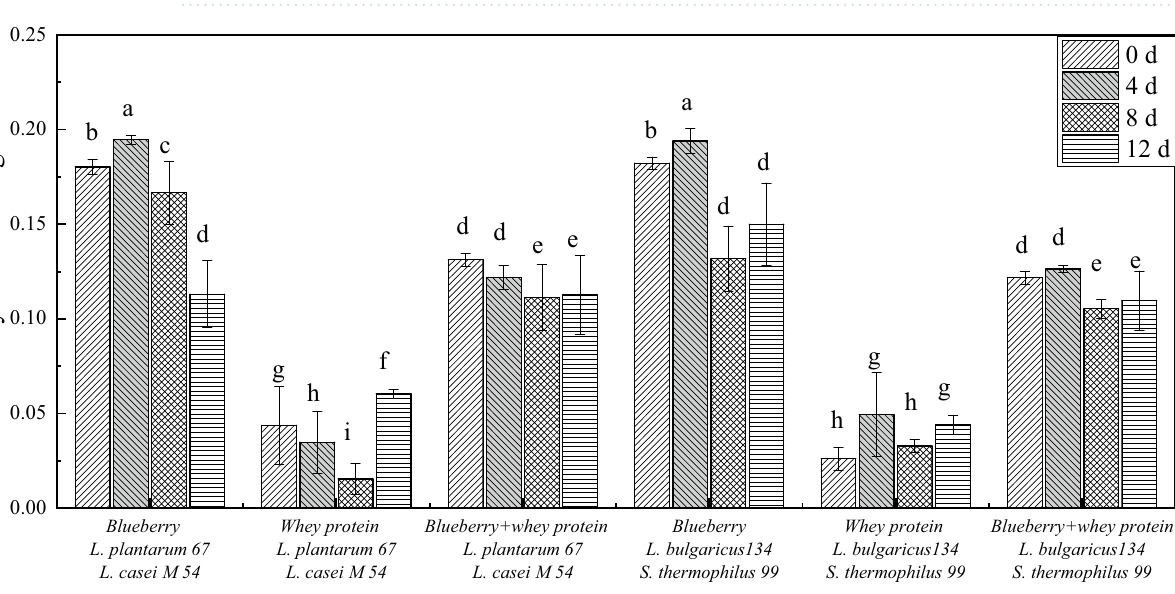
Figure 2. The survival curve of E. coli after the treatment of whey protein and blueberry juice mixture system fermented with Lactobacillus.